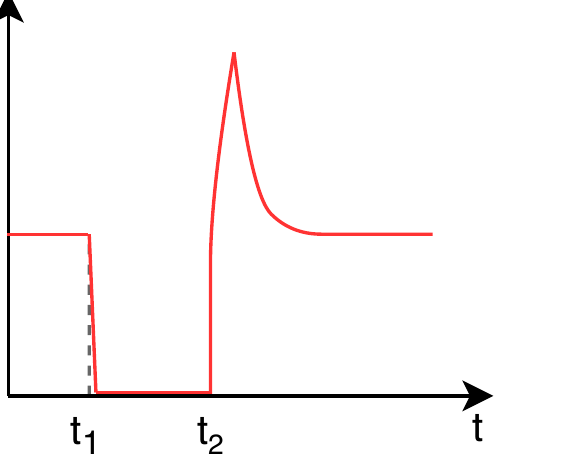
Figure 5. Behavior of velocity (V) and differential pressure ( ∆ P ) with respect to time (t) in the presence of a velocity excursion. PIG velocity.